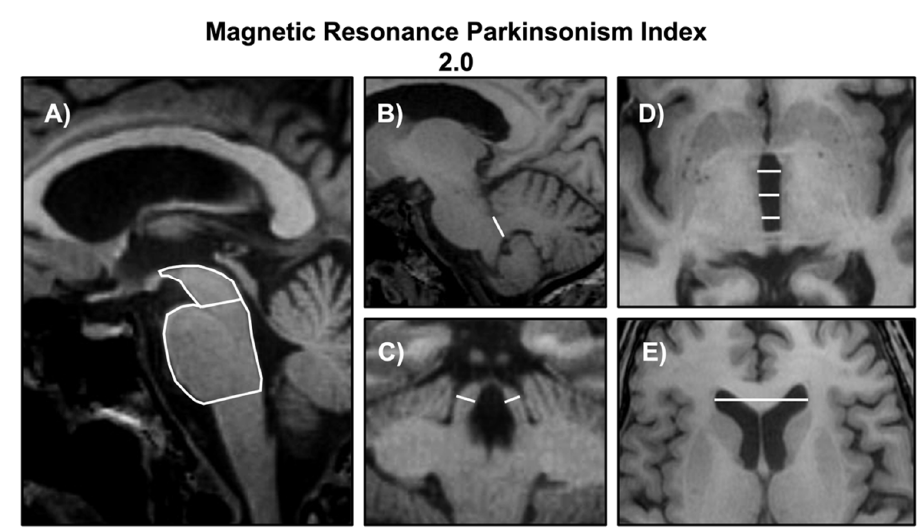
Figure 3. Manual measurements of the midbrain and pons area ( A ), the middle cerebellar peduncles (MCP) width ( B ), the superior cerebellar peduncles (SCP) width ( C ), the third ventricle width ( D ), and the frontal horns width ( E ) on T1-weighted magnetic resonance images in a patient with Parkinson’s disease. The measurements of midbrain and pons area ( A ) were performed on a midsagittal slice. The measurement of the MCP width ( B ) was performed on 3 consecutive parasagittal slices between the pons and the cerebellum for each side. The measurement of the SCP width ( C ) was performed bilaterally on 2 consecutive coronal slices where the peduncles and the inferior colliculi were separated. The measurement of the third ventricle width ( D ) was performed on a bi-commissural axial slice at the level of the anterior and posterior commissures; three measurements were performed at the level of the anterior, middle, and posterior sections of the third ventricle on the same axial slice. The measurement of the width of the frontal horns of lateral ventricles was performed on an axial slice at the level of their maximal dilatation. Table 2. Studies that assessed the diagnostic performance of combined MR planimetric biomarkers in distinguishing between progressive supranuclear palsy ‐ Richardson’s syndrome and Parkinson’s disease.